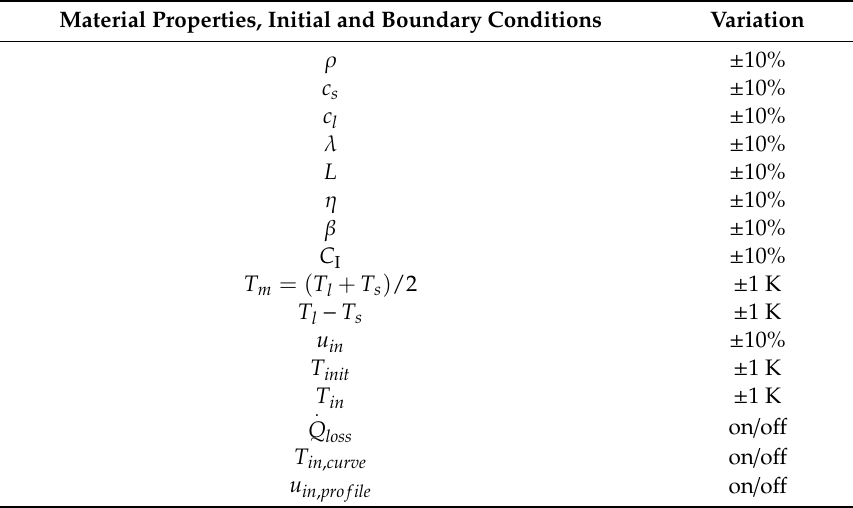
Table 4. Varied material properties and initial and boundary